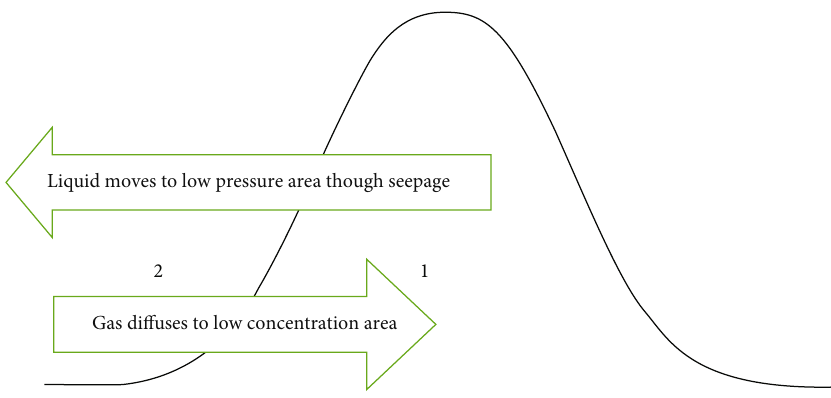
Figure 13: Schematic diagram of gas-liquid two-way transfer in fractured